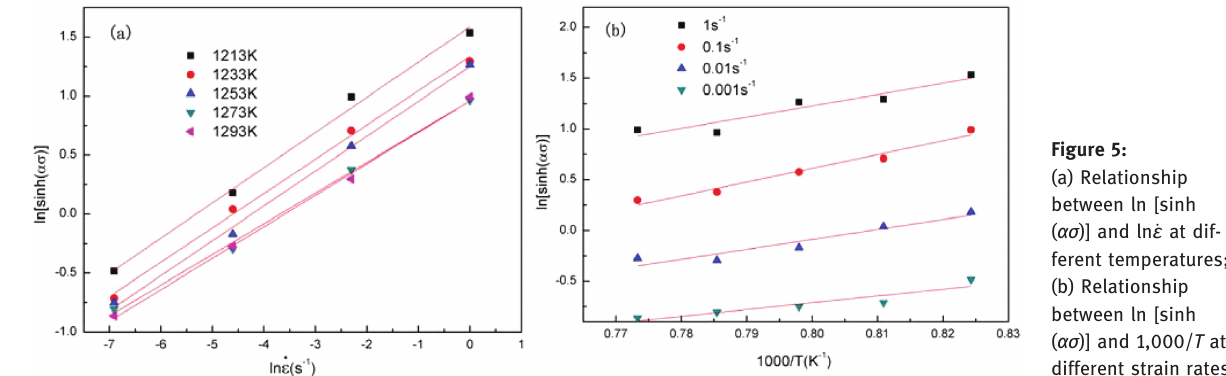
Figure 5: (a) Relationship between ln [sinh ( ασ )] and ln _ ε at dif- ferent temperatures; (b) Relationship between ln [sinh ( ασ )] and 1,000/ T at different strain rates.